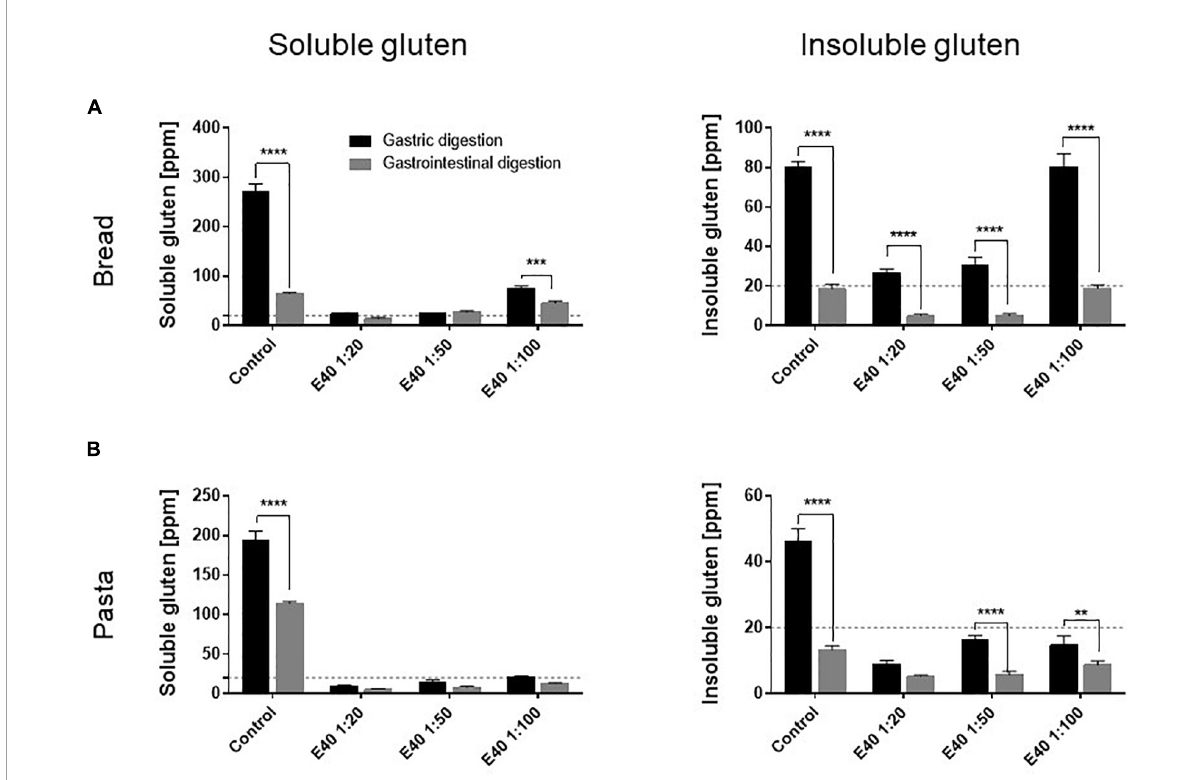
FIGURE3 Gluten degrading efficiency in bread (A) and pasta (B) samples during gastric and gastrointestinal digestion. Left panel: residual gluten content in its soluble form as assessed by competitive R5 ELISA. Right panel: residual gluten content in its insoluble form as assessed by sandwich R5 ELISA. Dotted line: 20 ppm, the threshold for gluten-free food. Data are shown as mean ± SD of n = 3 repetitions. Data were analyzed by one-way ANOVA ( p < 0.0001 for all) followed by post hoc Bonferroni tests, *: 0.01 < p < 0.05; **: 0.001 < p < 0.01; ***: 0.0001 < p < 0.001; ****: p < 0.0001.